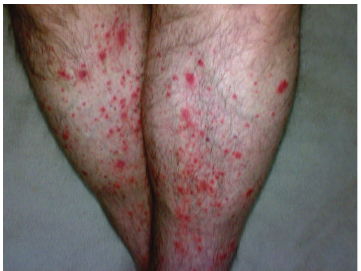
Figure 1: Bilateral palpable purpura in lower extremities.